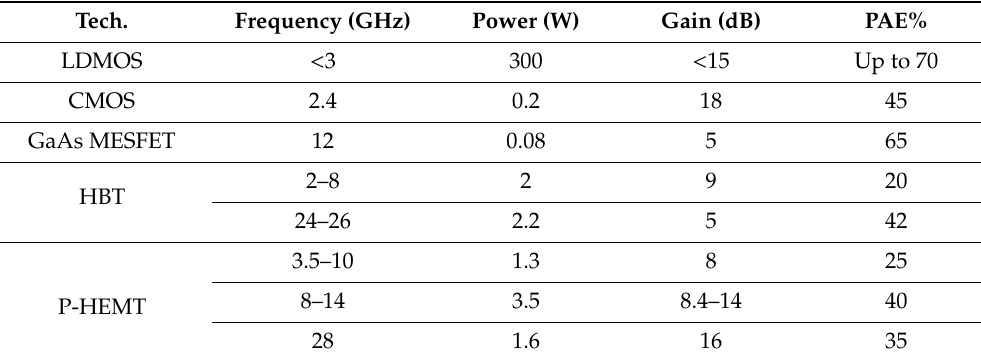
Table 1. Performance comparison of common semiconductors [15–18].